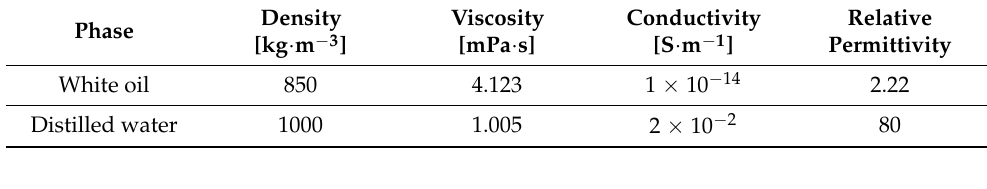
Table 1. Physical properties of experimental liquids.